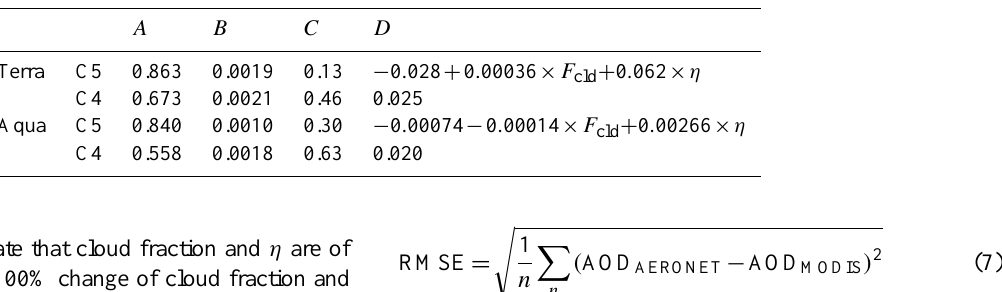
Table 2. Coefficients for Terra and Aqua in Eq. (6) AOD new =AOD old × (A − B × F cld + C × η) + D for C5 and C4